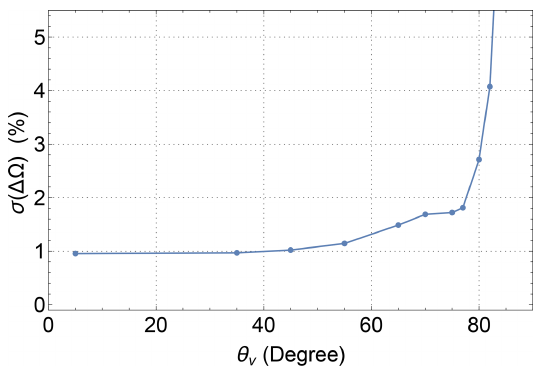
Figure 19. The standard deviation ( σ ) of O 3 errors due to profile mismatches as a function of the viewing zenith angle ( θ v ), esti- mated using the M2TCO3 profile covariance matrix for the Decem- ber midlatitude zone (40–50 ◦